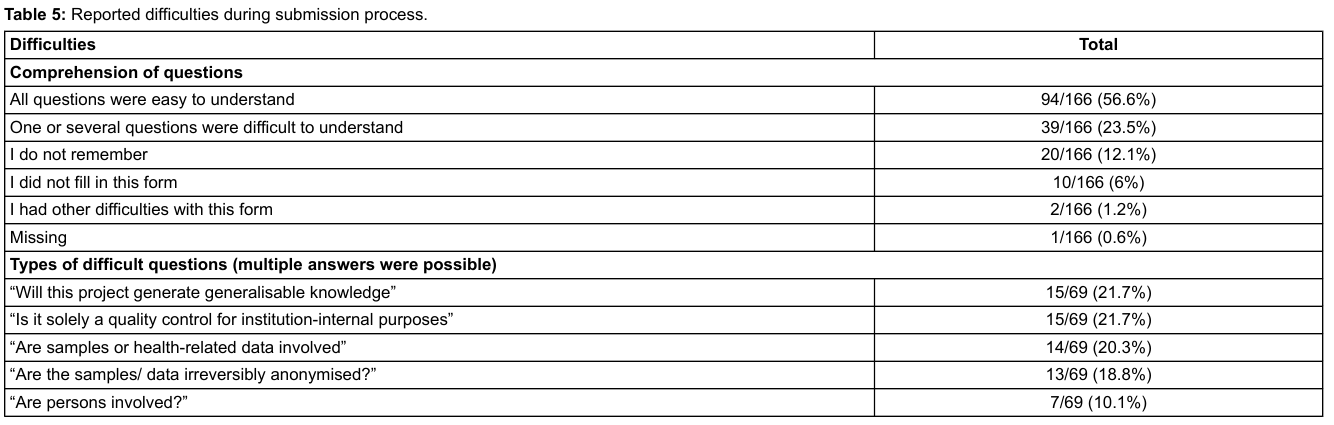
Table 5: Reported difficulties during submission